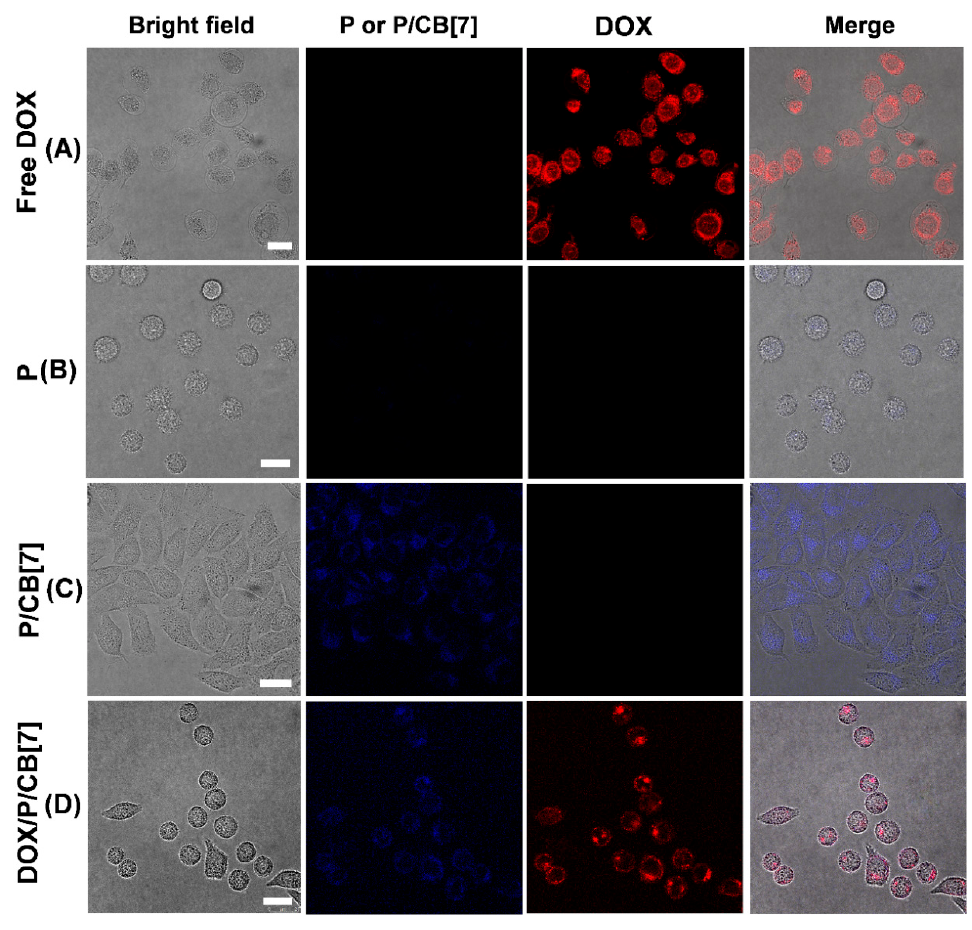
Figure 6. Confocal laser scanning microscopy images of HeLa cells exposed to free DOX·HCl ( A ), mPEG- b -QP4VP (P) ( B ), pseudopolyrotaxanes ( C ), and DOX/pseudopolyrotaxanes ( D ) after incubation for 4 h. The DOX concentration is 10 μ g/mL. Scale bars = 25 μ m.